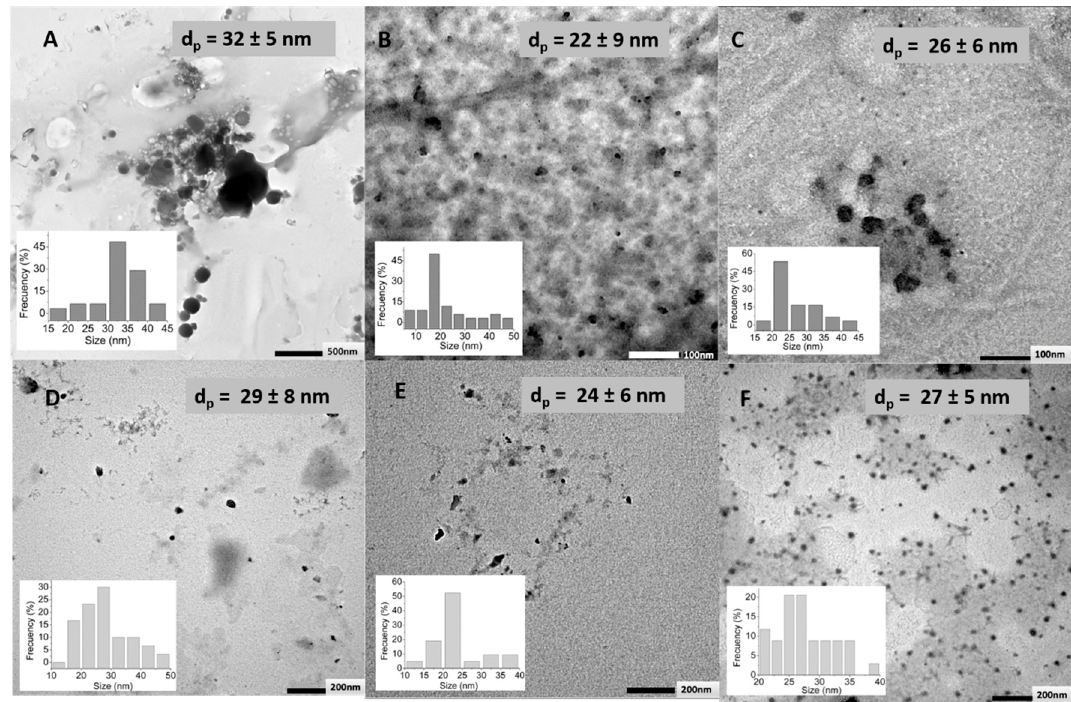
Figure 6. TEM microphotograph of ( A ) HA (LMW)–BDDE 1:0.2, ( B ) HA (LMW)–BDDE 1:1, ( C ) HA (LMW)–BDDE 1:10, ( D ) HA (HMW)–BDDE 1:0.2, ( E ) HA (HMW)–BDDE 1:1, and ( F ) HA (HMW)–BDDE 1:10 nanoparticles average particle sizes (d p ) and particle size distributions.